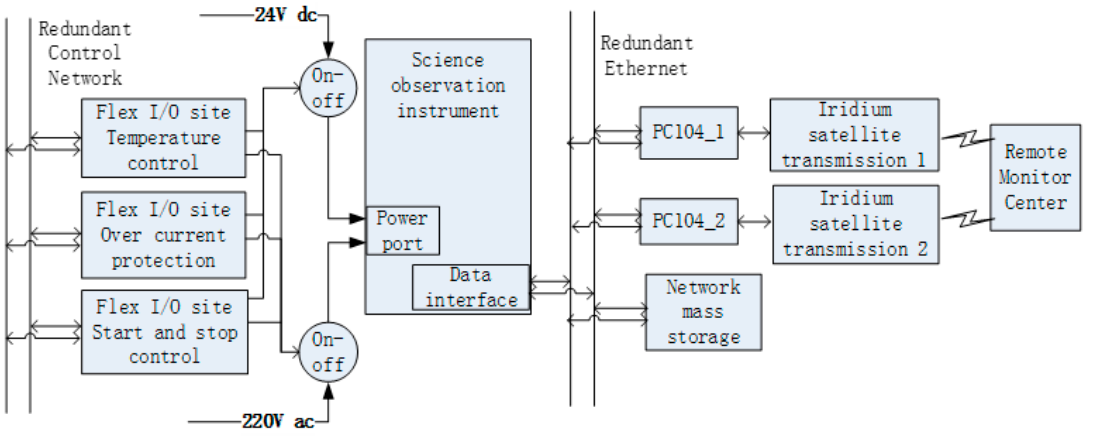
Figure 7. Interfaces for the science instruments.